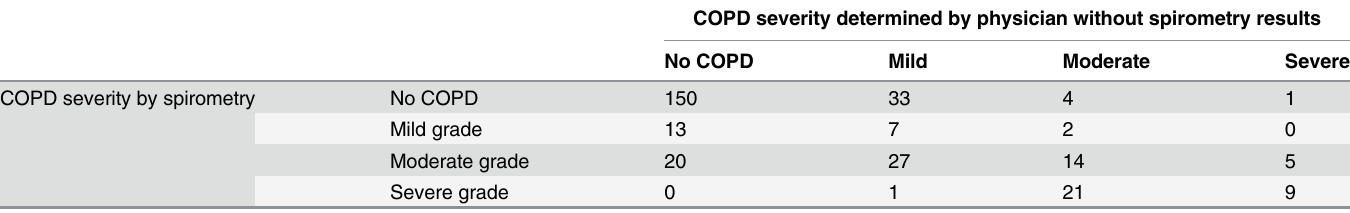
Table 3. The coherence between COPD severity determined by spirometry and physician without spirometry. COPD severity determined by physician without spirometry results